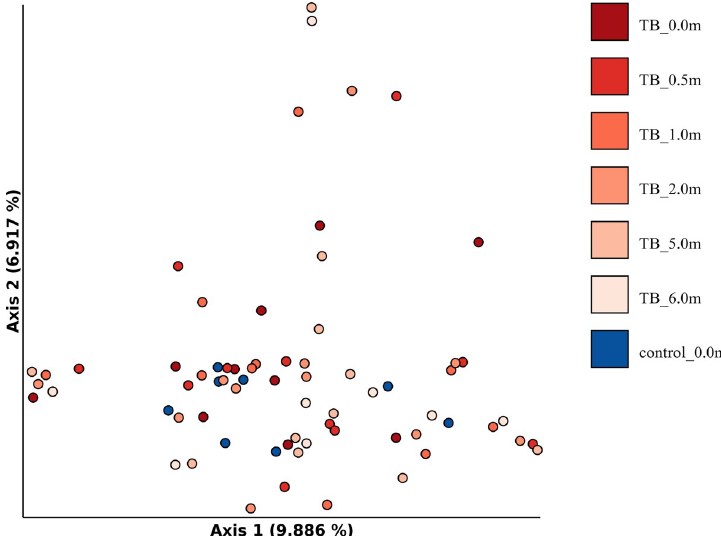
Fig 6. Principal component analysis (PCoA) of the sputum samples collected in Bangladesh. The analysis is based on Bray-Curtis distances and shows control and TB patients at the different time-points.